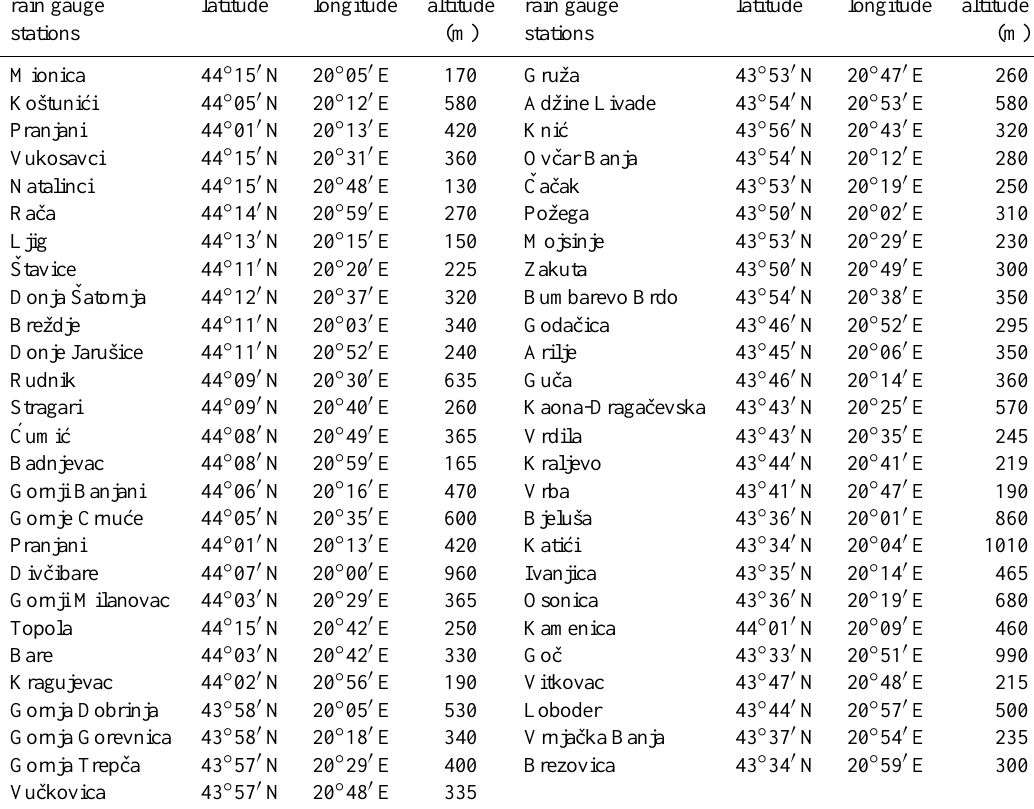
Table 1. Geographic coordinates and altitudes of rain gauge stations in the study